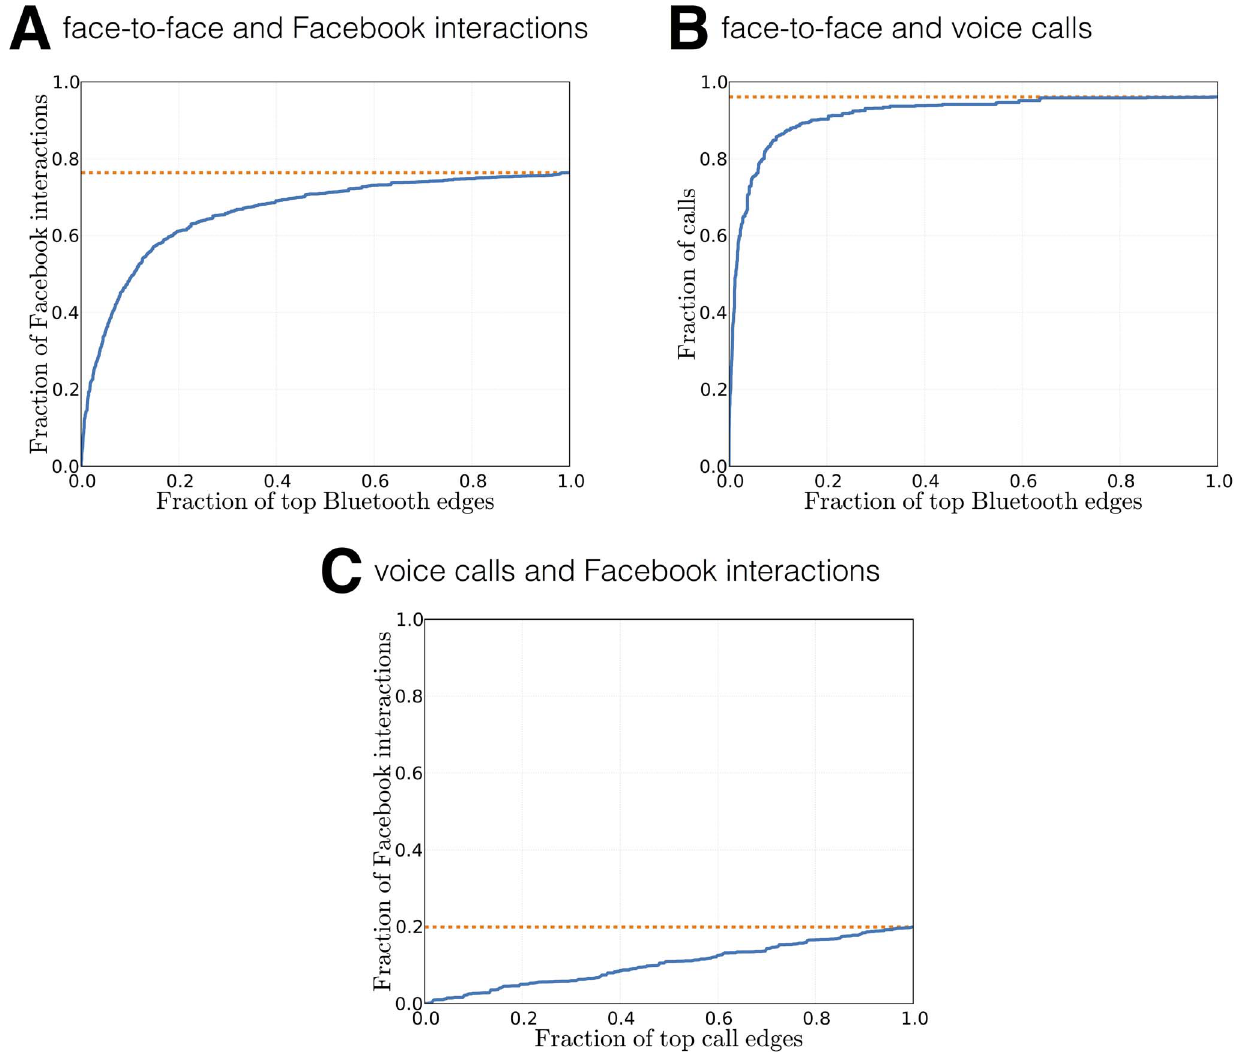
Figure 13. Network similarity. Defined as the fraction of ties from one communication channel that can be recovered by considering the top k fraction of edges from a different channel. Orange dashed line indicates the maximum fraction of ties the network accounts for. The strongest 10 % of face-to-face interactions account for w 50 % of online ties and * 90 % of call ties, while 23 : 58 % of Facebook ties and 3 : 85 % of call ties are not contained in the Bluetooth data. Between call and Facebook, the 10 % strongest call ties account for v 3 % while in total w 80 % of Facebook ties are unaccounted. All values are calculated for interactions that took place in January 2014.